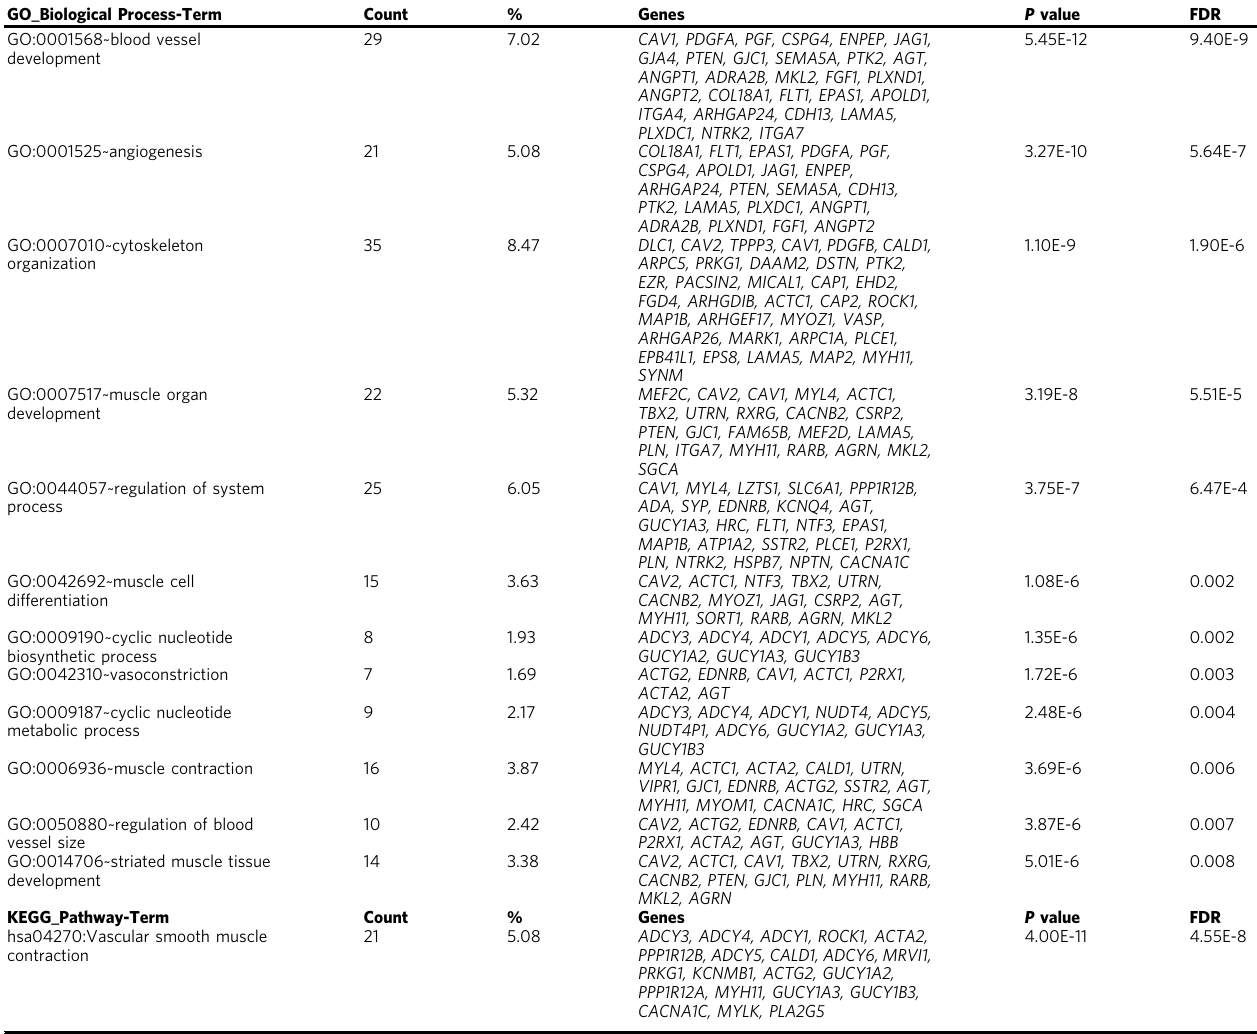
Table 3 Signi fi cant enriched pathways for genes upregulated in CAF-S4 versus CAF-S1 GO_Biological Process-Term Count %